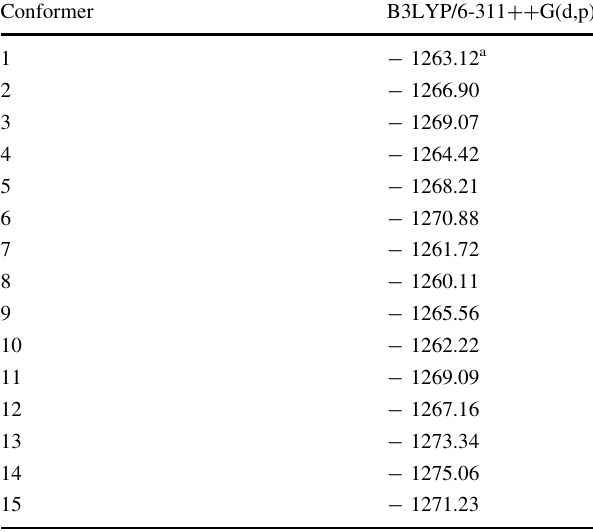
Table 2 Optimized global minimum energies of different conformers of curcumin calculated at B3LYP/6 - 311 ?? G(d,p) level of theory